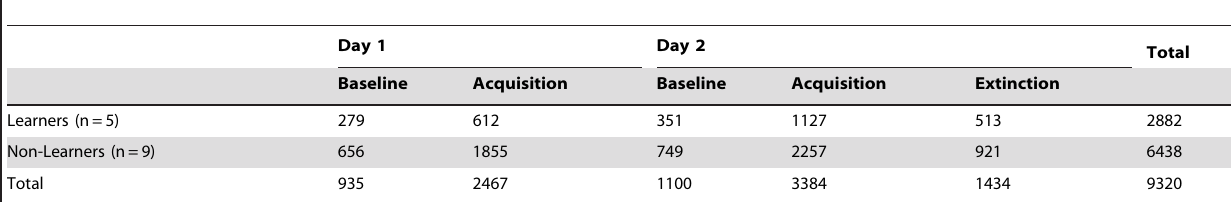
Table 1. Learners versus non-learners: number of kicks analyzed during each condition.